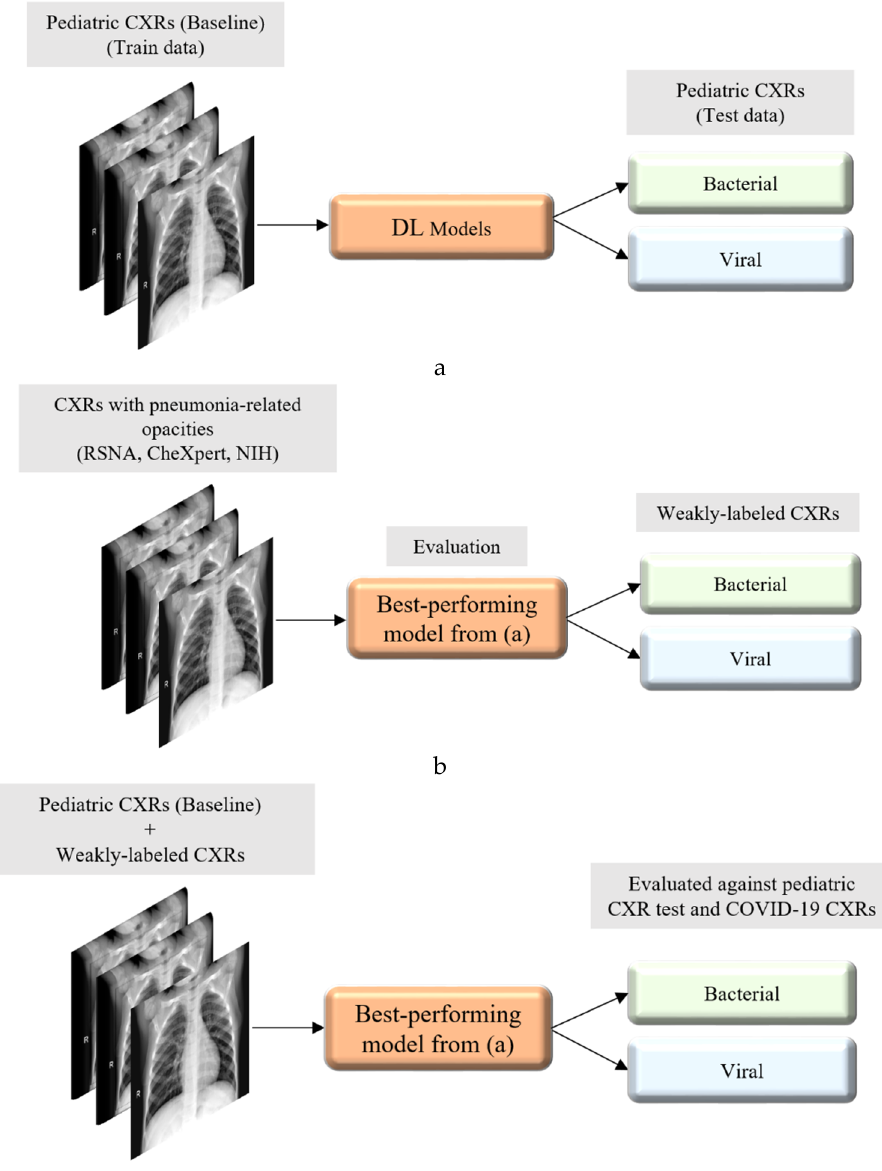
Figure 2. Graphical abstract of the proposed study. ( a ) Model training and evaluation with baseline pediatric CXR data; ( b ) using the best performing model from ( a ) to weakly classify CXRs from Radiological Society of North America (RSNA), National Institutes of Health (NIH), and CheXpert containing pneumonia-related opacities, as showing bacterial or viral pneumonia; and ( c ) augmenting the baseline training data with weakly labeled CXRs to check for performance improvement.